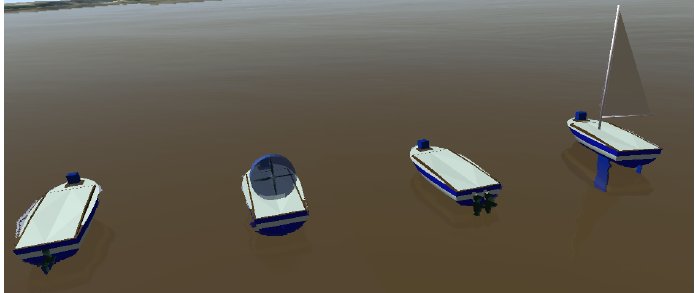
Figure 4. From left to right: the rudder boat, airboat, differential boat and sailboat available in the